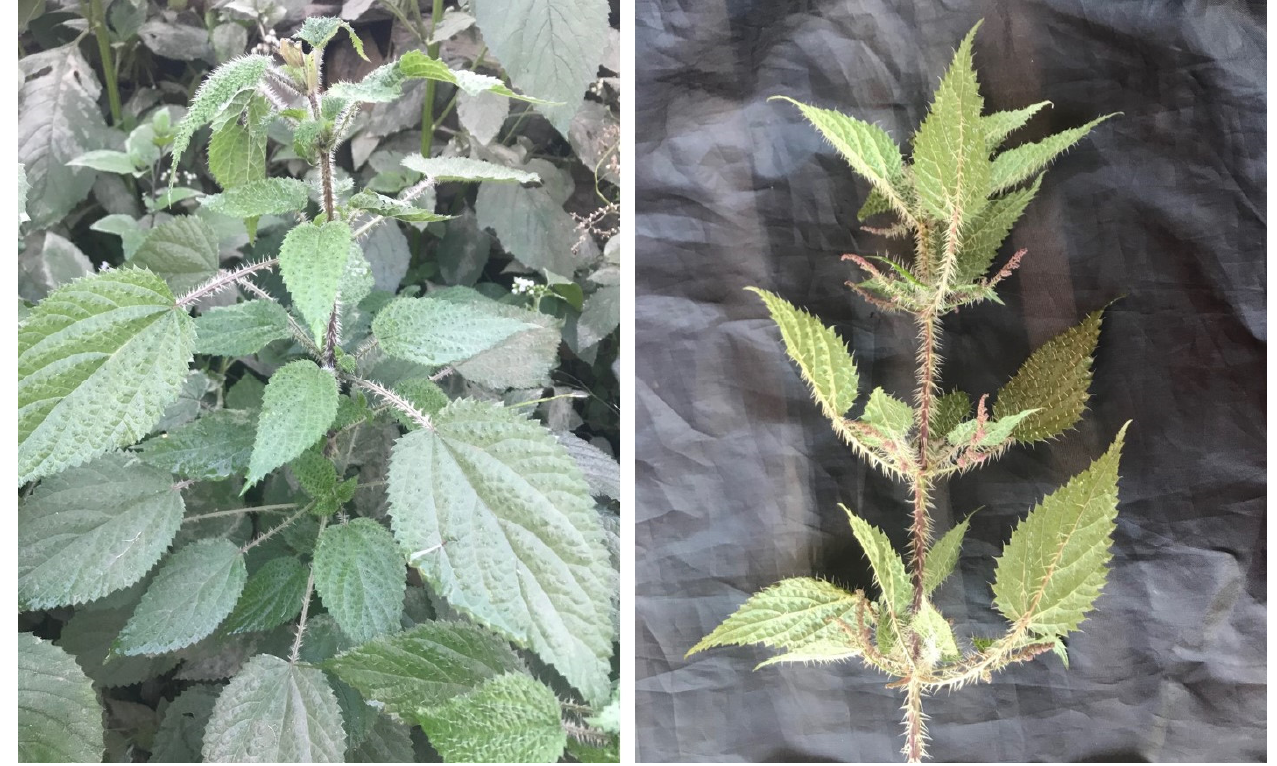
Figure 1. Photographs of Urtica dioica (photos by Mr. Prakash Poudel).